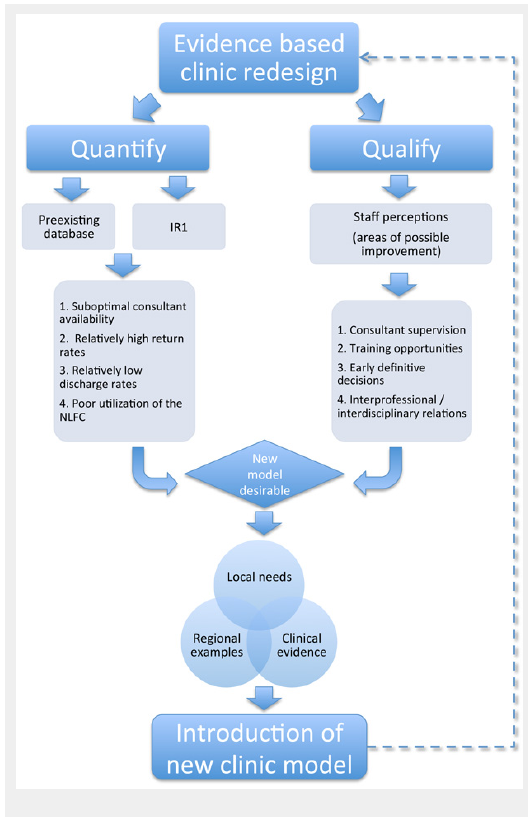
Implementation of new fracture clinic model using principles of evidence-based redesign.